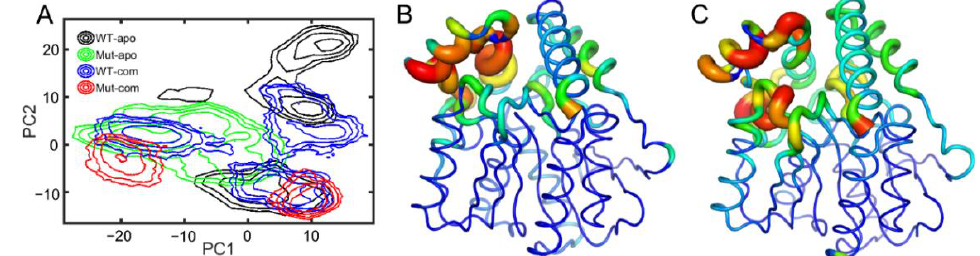
Figure 5. Free energy profiles over the first two principal components (PC1 and PC2) in all systems: WT-apo, Mut-apo, WT-com, and Mut-com ( A ). The displacements of the protein along PC1 ( B ) and PC2 ( C ) are mapped onto the structure. The detailed motions along the two PCs are displayed in Supplementary Videos S1 (PC1) and S2 (PC2). In the videos, the lid and cap regions are colored purple and yellow, respectively. Additionally, the Cα atoms of essential pocket residues are depicted as green spheres, including oxygen hole residues and triads.